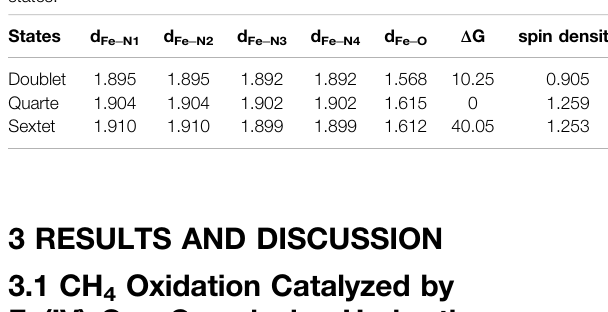
Frontiers in Chemistry |